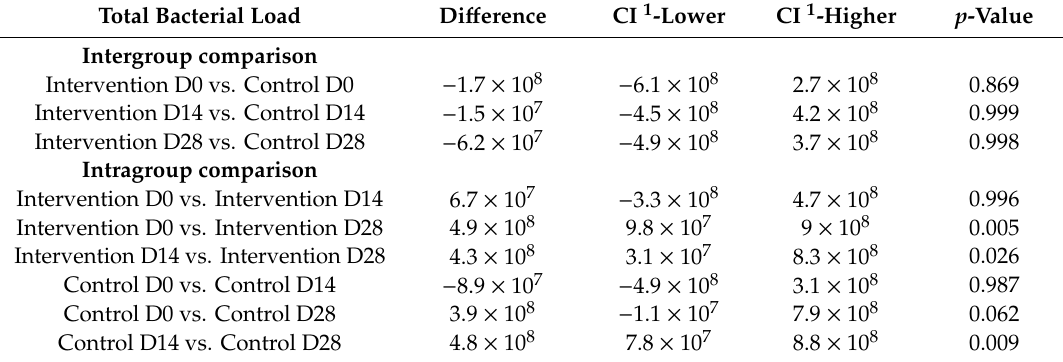
Table 2. Comparison of Total bacterial load in Intervention group vs. Control group.